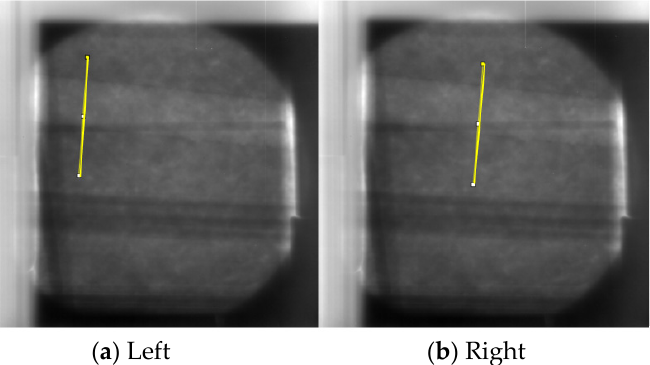
Figure 32. X-ray images of the model sample for a 750 mm-thick PC bridge taken by the 3.95 MeV source. The grout is partially filled. Wires are inserted. ( a ) Left; ( b ) Right.